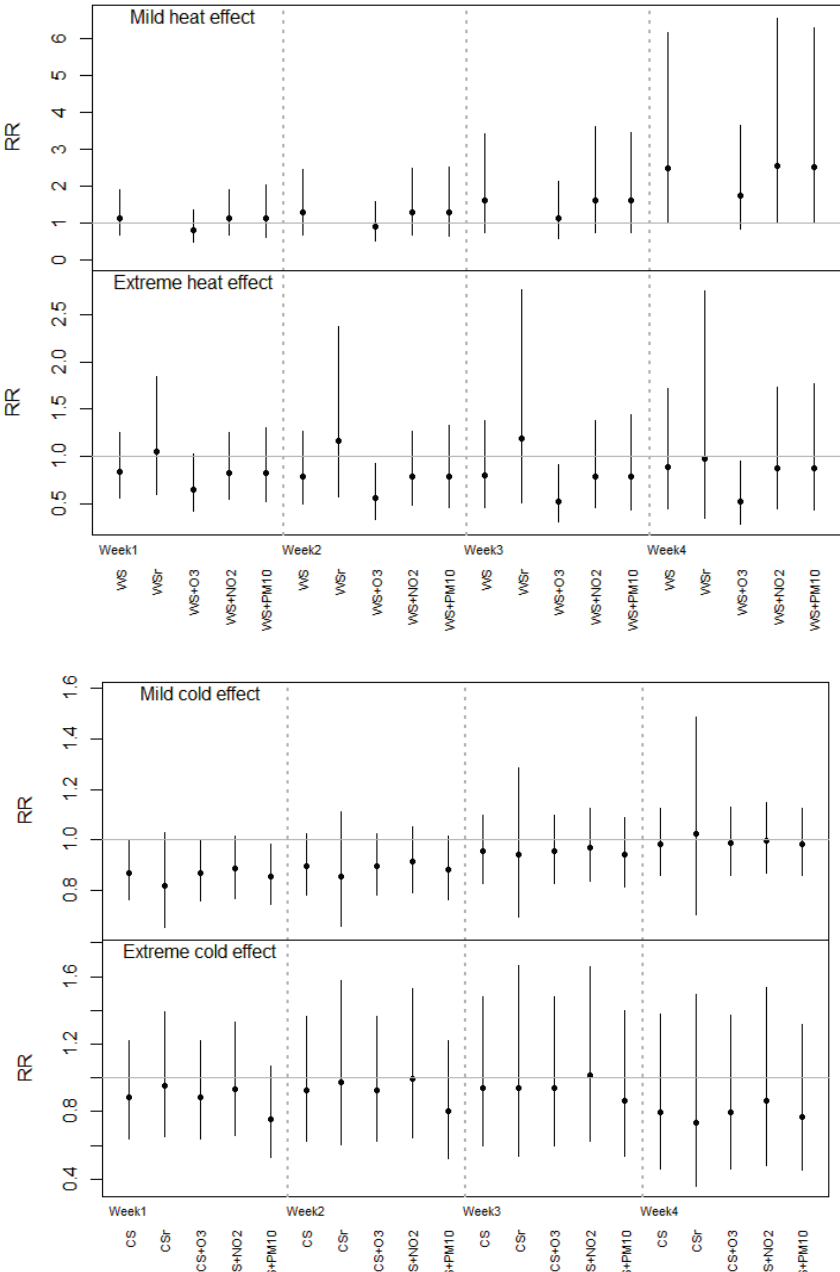
Figure 3. Cumulative risk ratios (RR) estimated up to the end of each week (from the 1st to 4th week after the exposure) for moderate/extreme heat and cold effects in the different